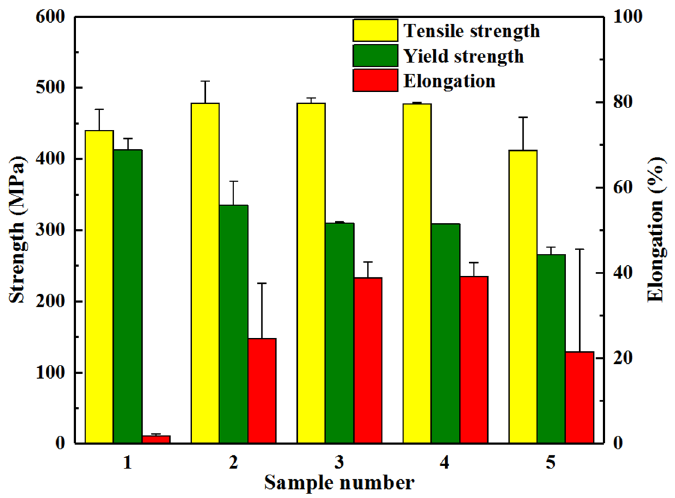
Figure 22. Tensile test results: 1. as-welded, 2. 720 °C 3. 770 °C 4. 820 °C 5. 870 °C. Table 5. Bending performance test report.